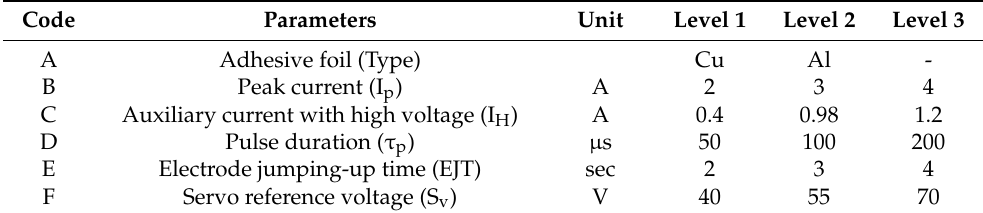
Table 5. Machining parameters and their levels.